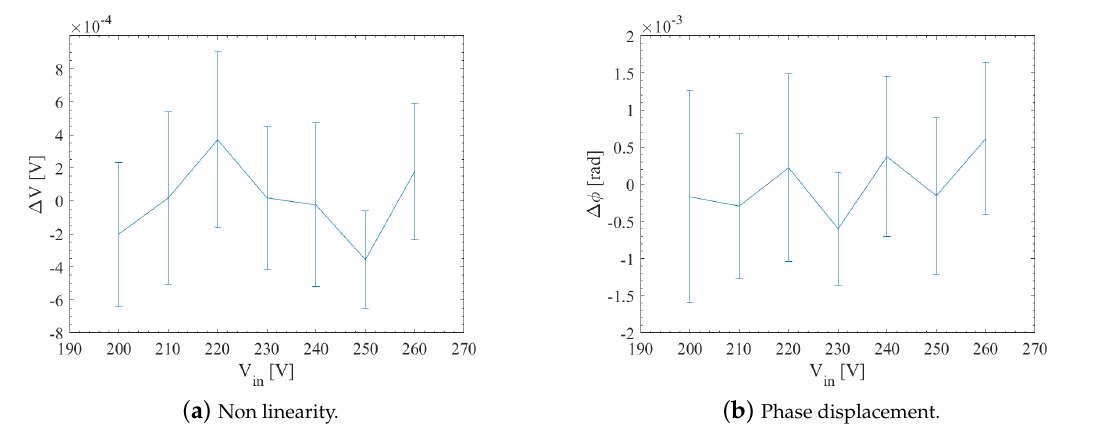
Figure 5. Performance parameters of the adopted voltage